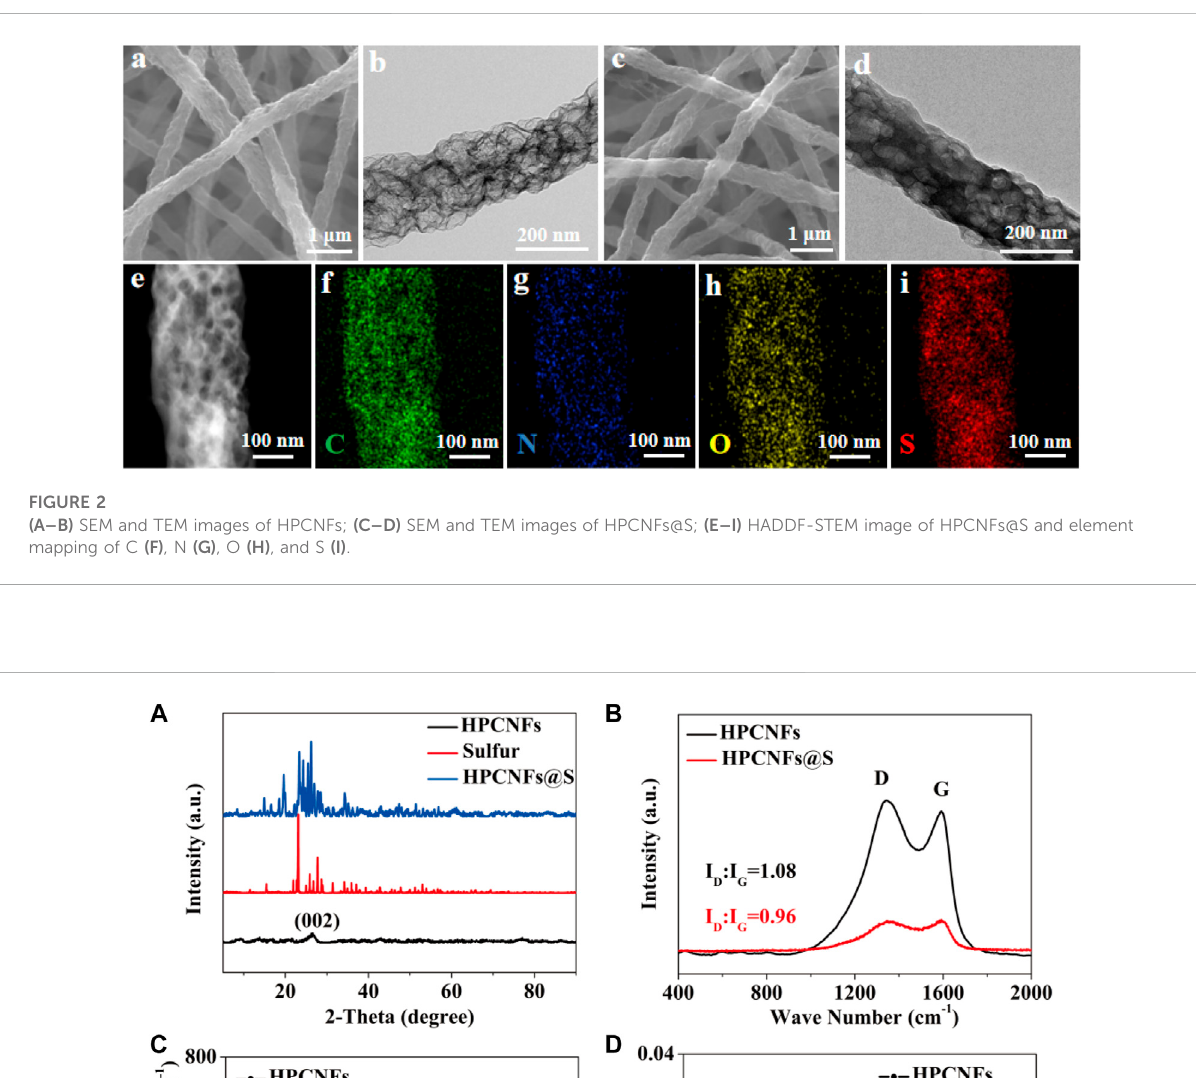
HPCNFs resulted from completely thermal decomposition ZIFs-8 particles after carbonization (Figure 2B). As shown in Figure 2C, after the sulfur in fi ltrated in HPCNFs, the